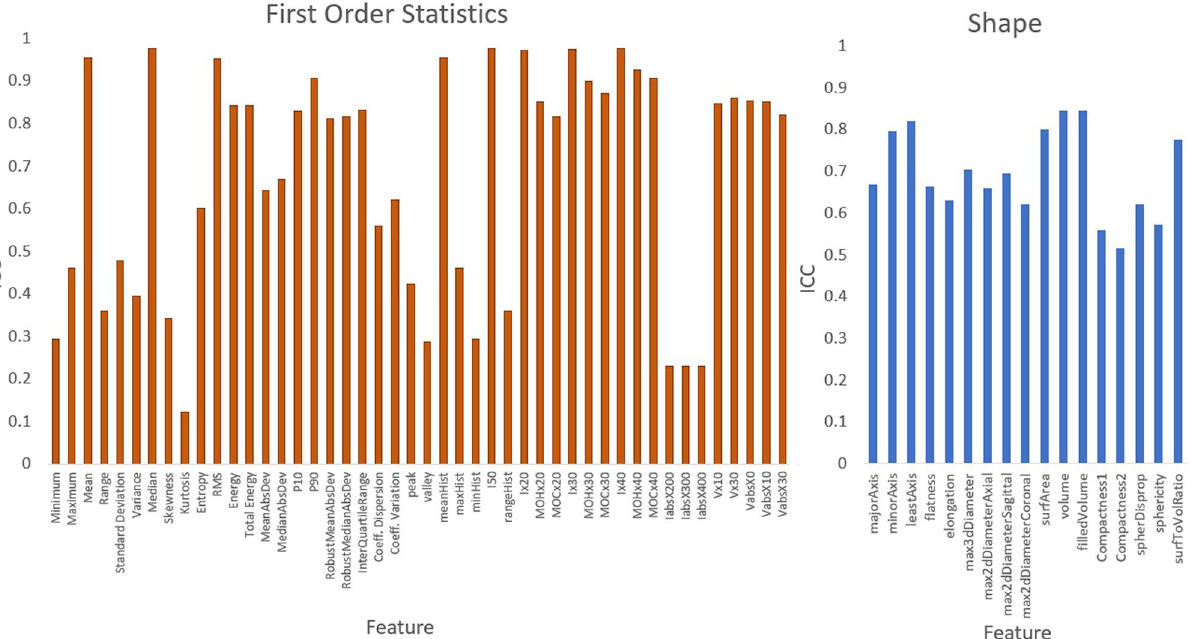
Figure 3. ICC for First order and Shape Features for radiation oncology derived contours only. Features with ICC values > 0.75 were considered robust. Plots of other feature classes are included in Supplement Figures S1– S7 with ICC values from both